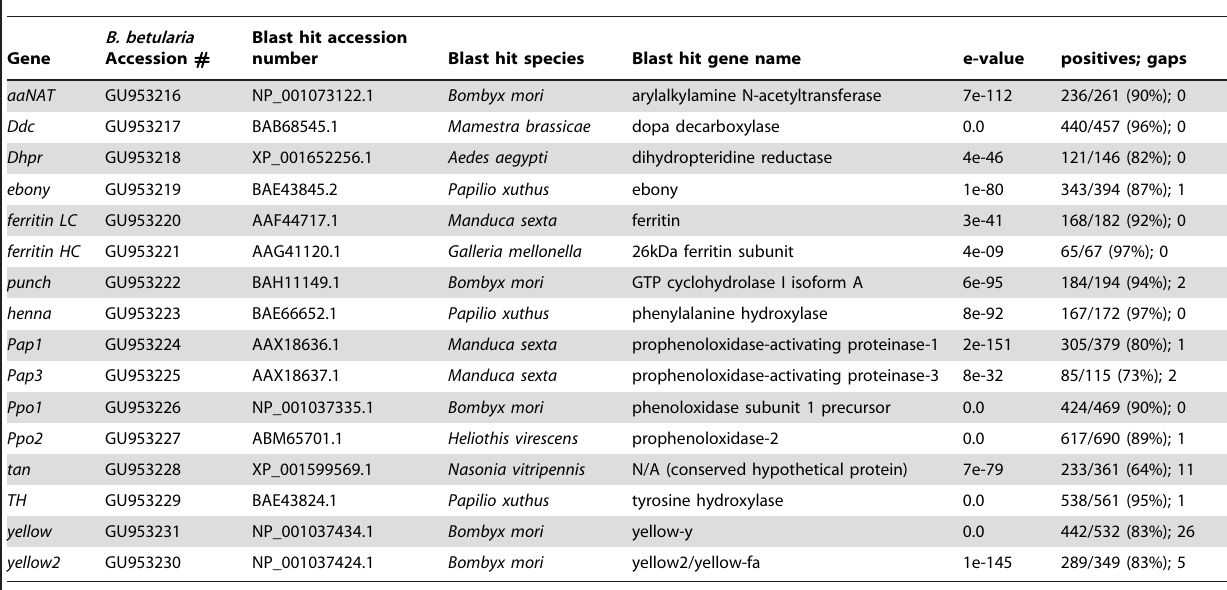
Table 1. NCBI blastx ‘best